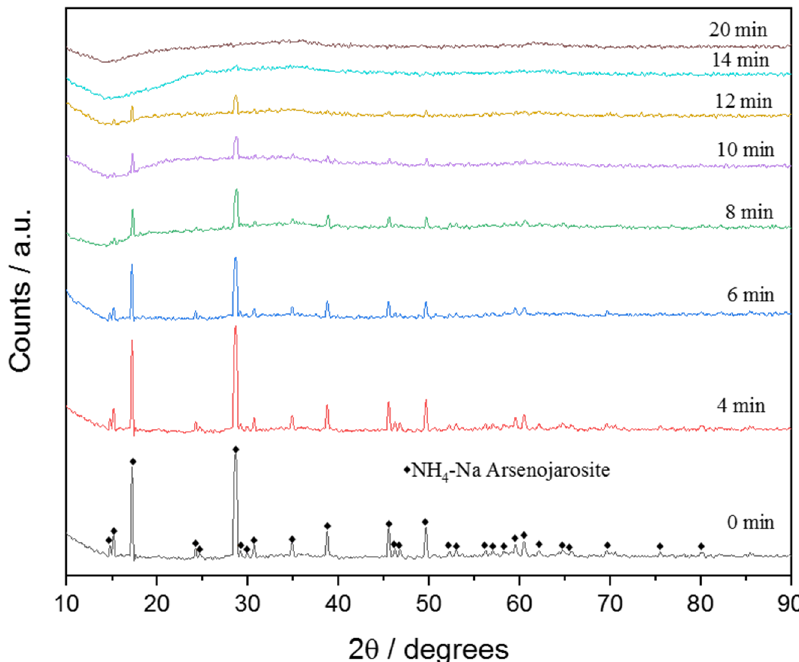
Figure 7. Diffractograms at different reaction times in NaOH media.